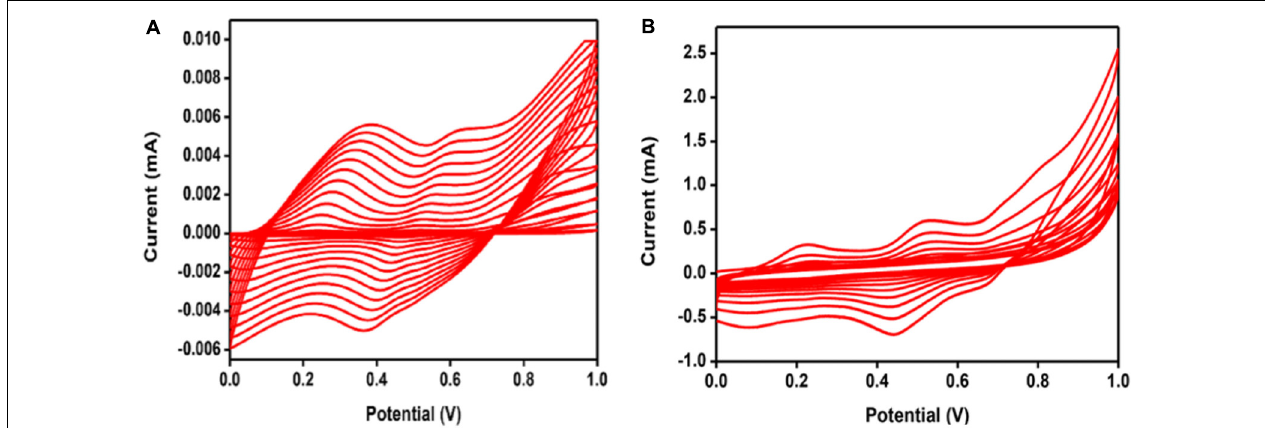
FIGURE 2 | Cyclic voltammogram recorded during the synthesis of (A) PANI and (B) PANI/GO composite for 20 potential cycles.